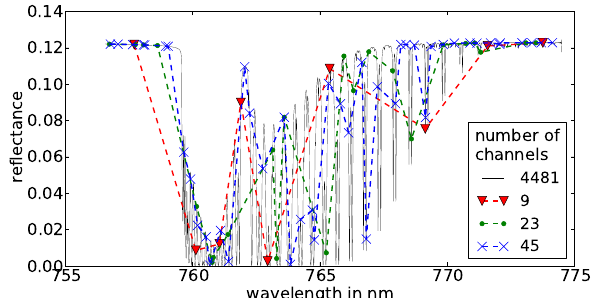
Fig. 8. Similar to Fig. 6, but the optimization technique was used.